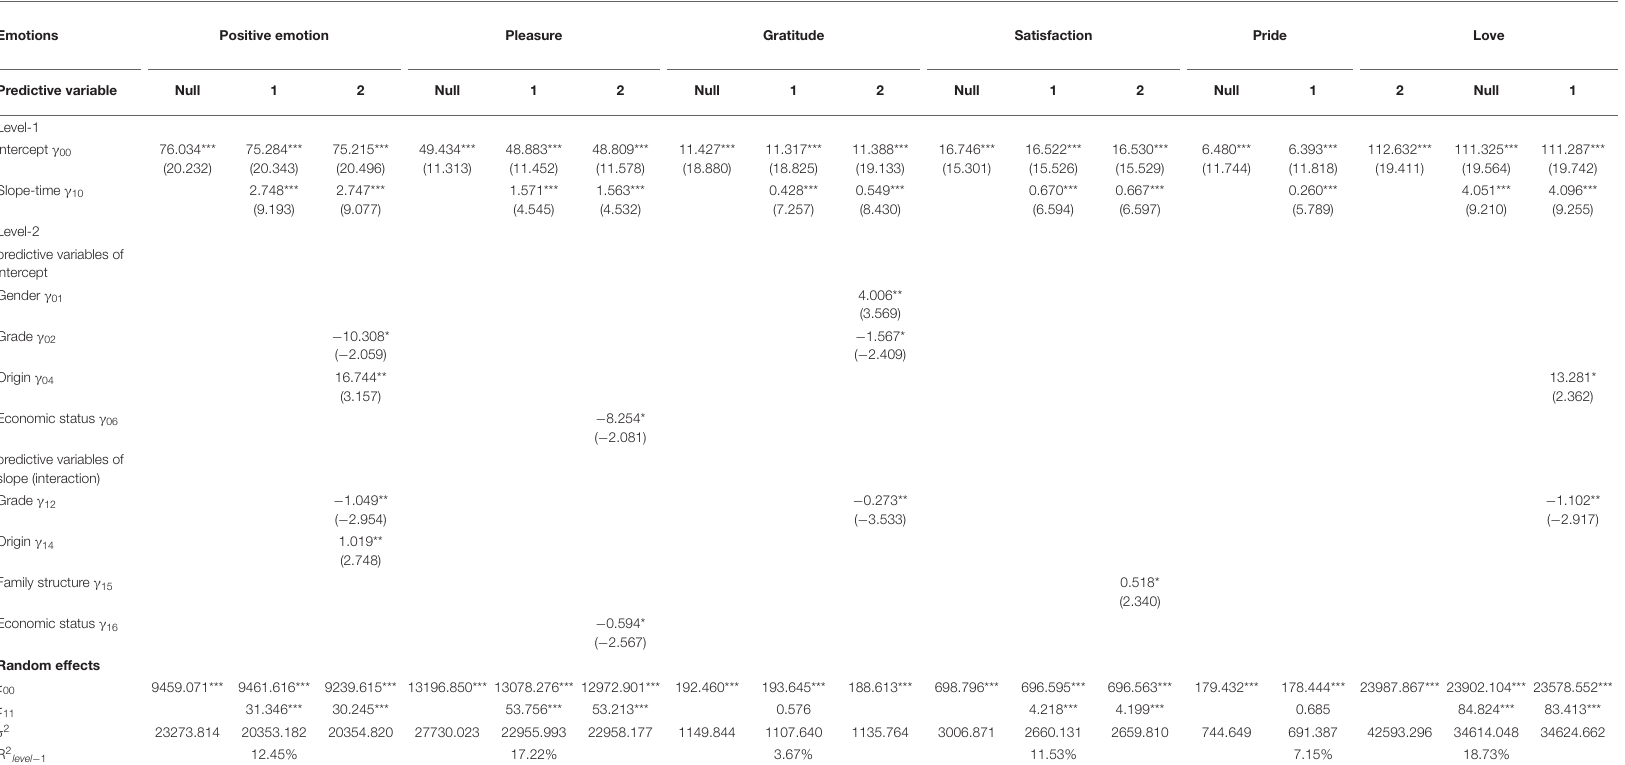
TABLE 3 | Multilevel linear model of positive emotion and its subcategories. Emotions Positive emotion Pleasure Gratitude Satisfaction Pride